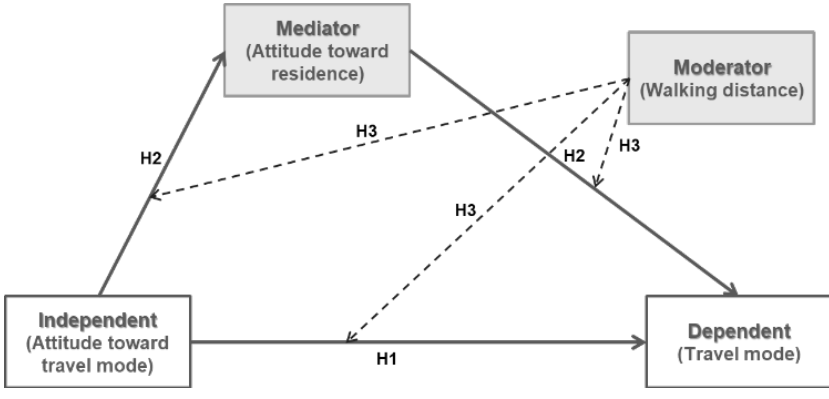
Figure 1. The conceptual moderated mediation model.